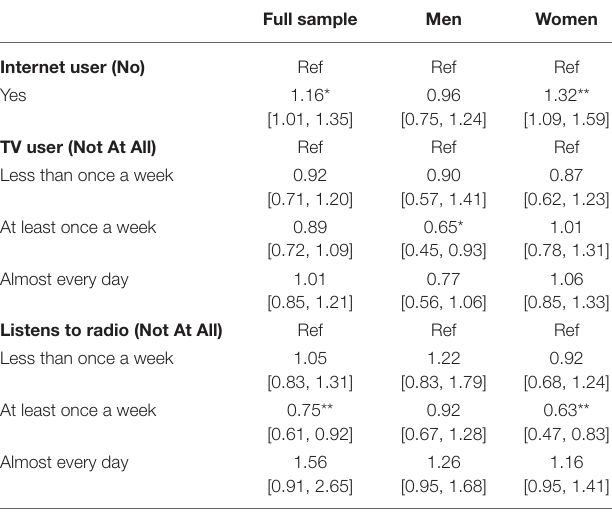
TABLE 2 | Association between electronic media use and tobacco smoking among adult men and women in Guyana (2019–20).